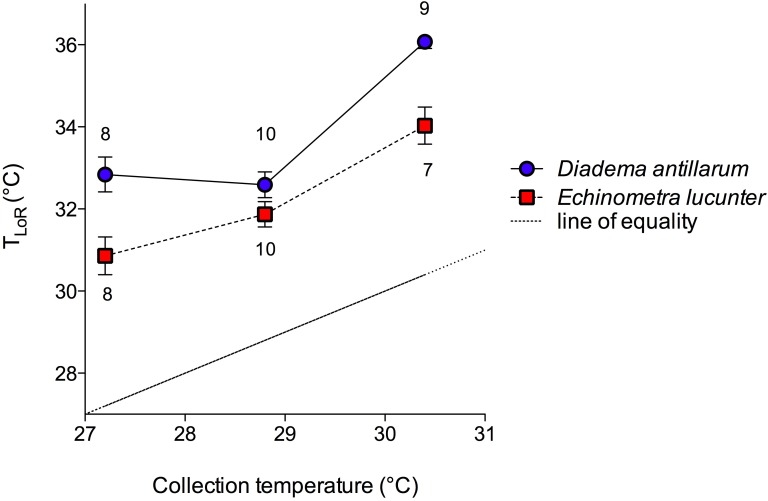
Temperature at the loss of righting (TLoR) of D. antillarum and E. lucunter at different collection temperatures.The symbols represent mean TLoR with vertical lines representing 1 SEM. Sample sizes are indicated above or below the symbol. The dotted line represents the line of equality, TLoR = sea temperature. The thermal safety margin is the distance between the fitted lines and the line of equality. The main effects of species (F1,46 = 29.51, p < 0.0001) and collection temperature (F2,46 = 48.17, p < 0.0001) were significant predictors of TLoR but their interaction was not (F2,46 = 2.189, p = 0.12).